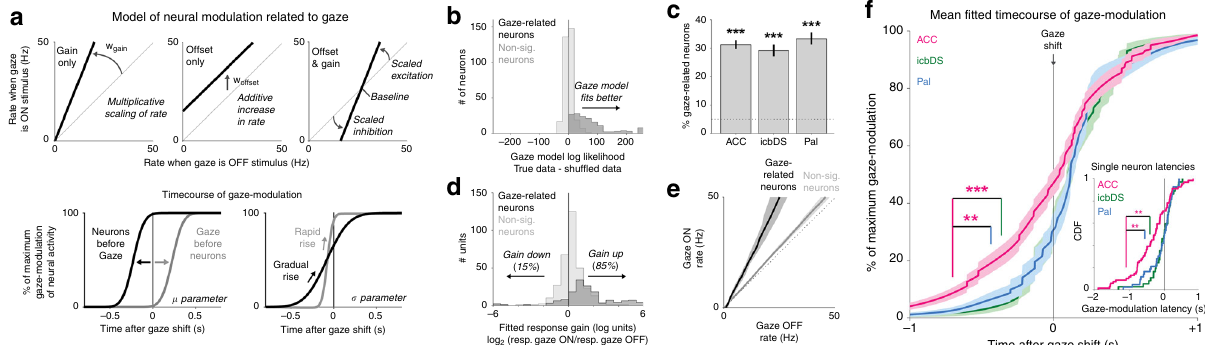
Fig. 6 Prevalence and dynamics of gaze shift-related activity in the cortico-basal ganglia network. a Model of gaze-related modulation in single neurons. Top: parameters fi tting the effect of gaze on neural activity as multiplicative scaling (left), additive increase or decrease in fi ring rate (middle), or both (right). Bottom: parameters fi tting the time course of gaze-modulation by setting the temporal offset between neural modulation and gaze shifts (left, neurons fi rst vs. gaze fi rst) and the rate that modulation builds up over time (right, gradual vs. rapid). b Model fi ts for each neuron evaluated by difference in log likelihood when fi tting the real data vs. shuf fl ed data. 31% of neurons were signi fi cantly modulated in relation to gaze (dark histogram, p < 0.05, permutation test); remaining neurons were not (light histogram). c Percentage of signi fi cantly gaze-related neurons (ACC n = 69/221, icbDS n = 37/127, Pal n = 43/129). Error bars are ± 1 SE. *** indicates p < 0.001 (binomial test). d Fitted gaze-related response gains in each neuron in log 2 units (0 = no